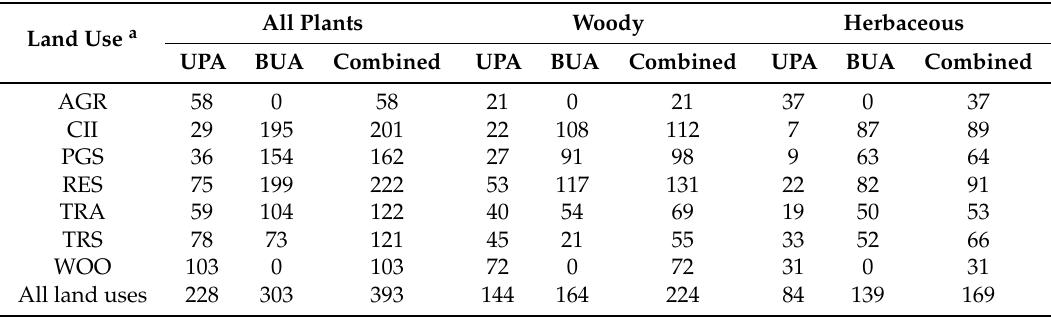
Table 2. Plant species richness of different land uses in the built-up area (BUA) and the urban planning area (UPA).